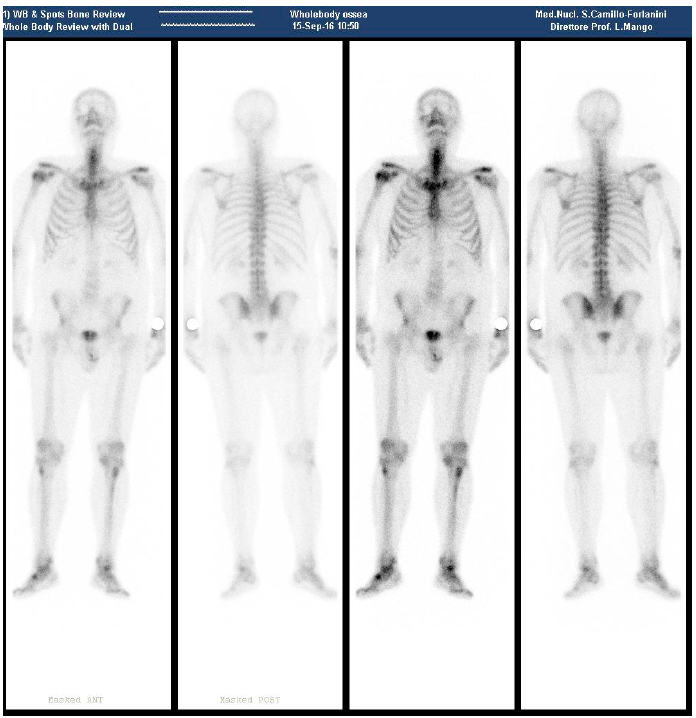
Figure 2. (September 2016—Bone scan 4 months after 223 RaCl 2 last cycle, with no metastatic site, except for the surgical neck of the right humerus).